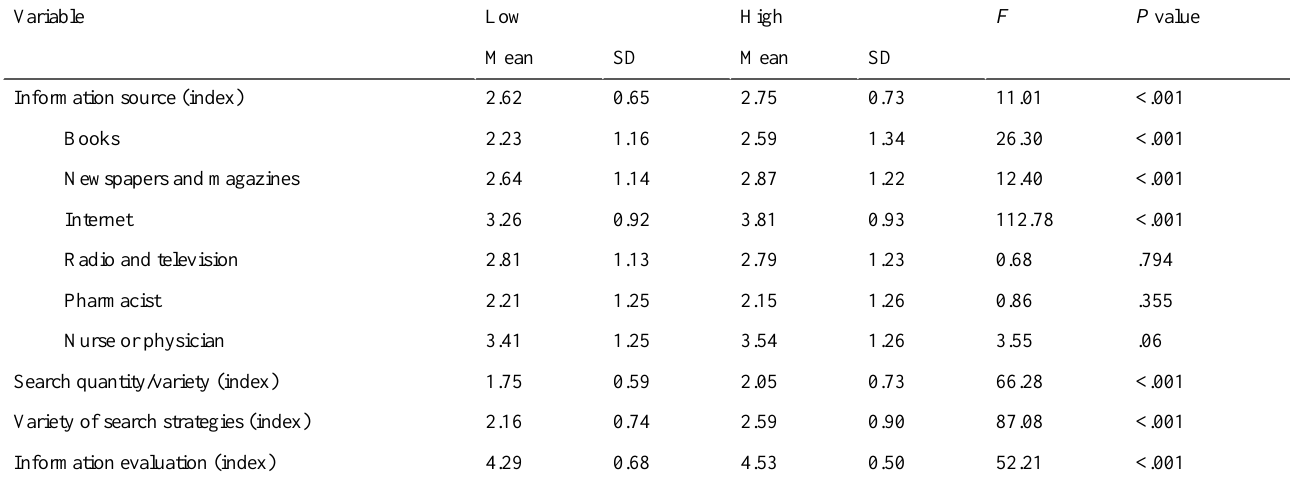
Table 1. Scores for low and high eHealth literacy groups’consumption of information on the Internet